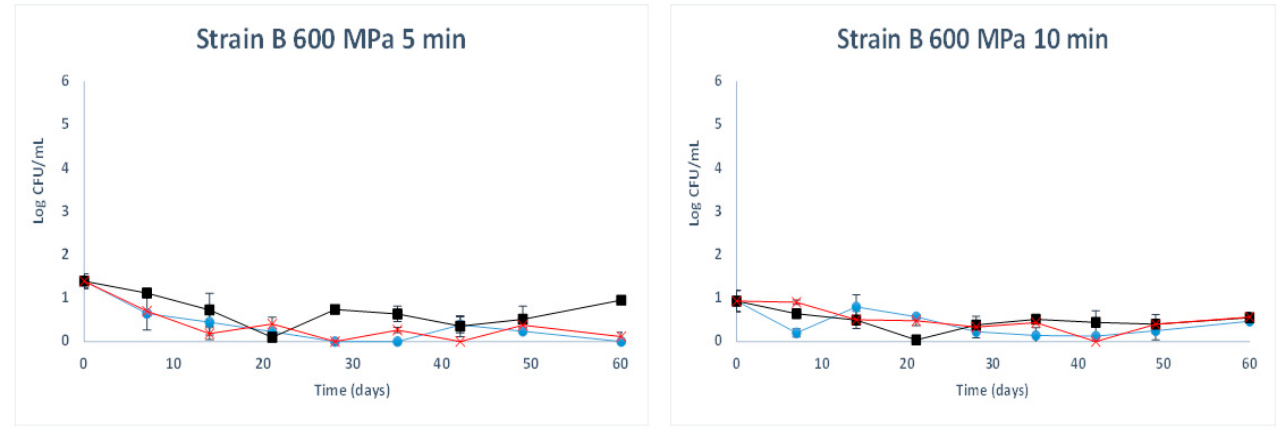
Figure 4. Survival curves of A. acidoterrestris (Strain B) vegetative cells treated at 600 MPa/60 °C for 5 and 10 min and stored at 4 °C ( ● ), 12 °C ( ■ ) and 25 °C (x). Data points are mean values ± standard deviation of duplicate samples from two independent experiments ( n = 4).